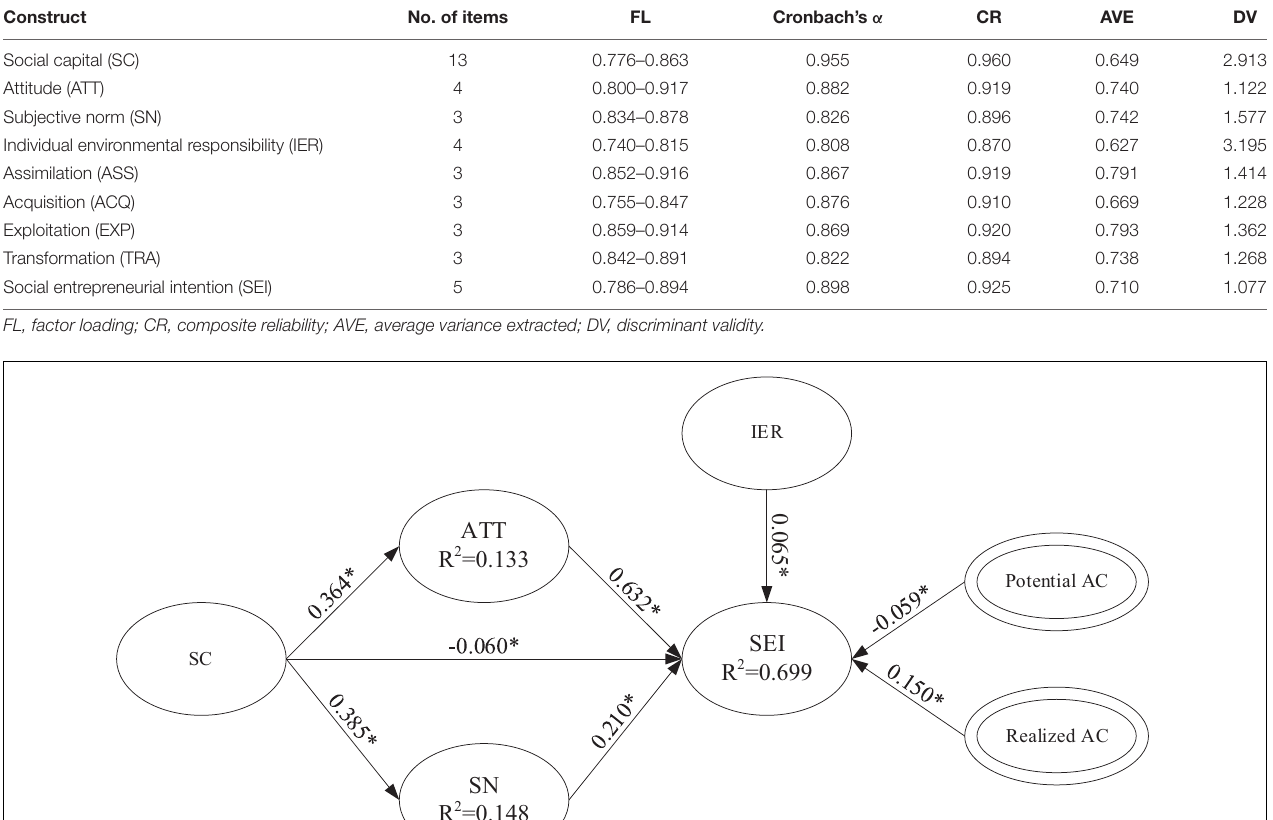
TABLE 2 | Factor loadings, Cronbach’s alpha ( α ), CR, AVE.